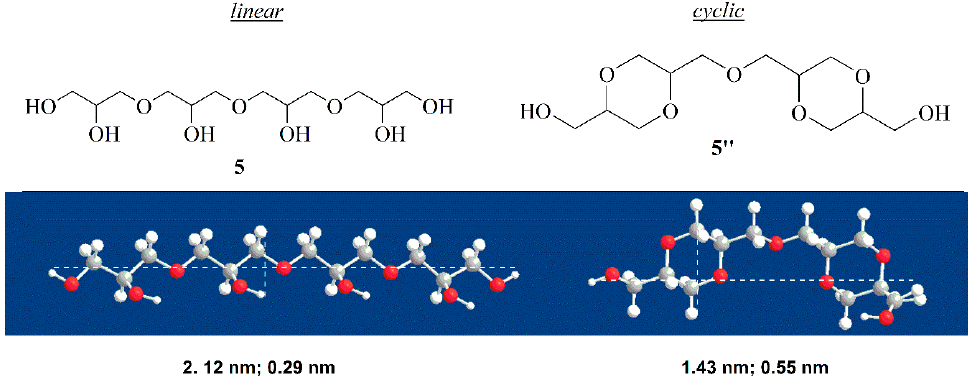
Figure 9. Determination of dimensions for tetramer 5 and 5” with Chem3D.